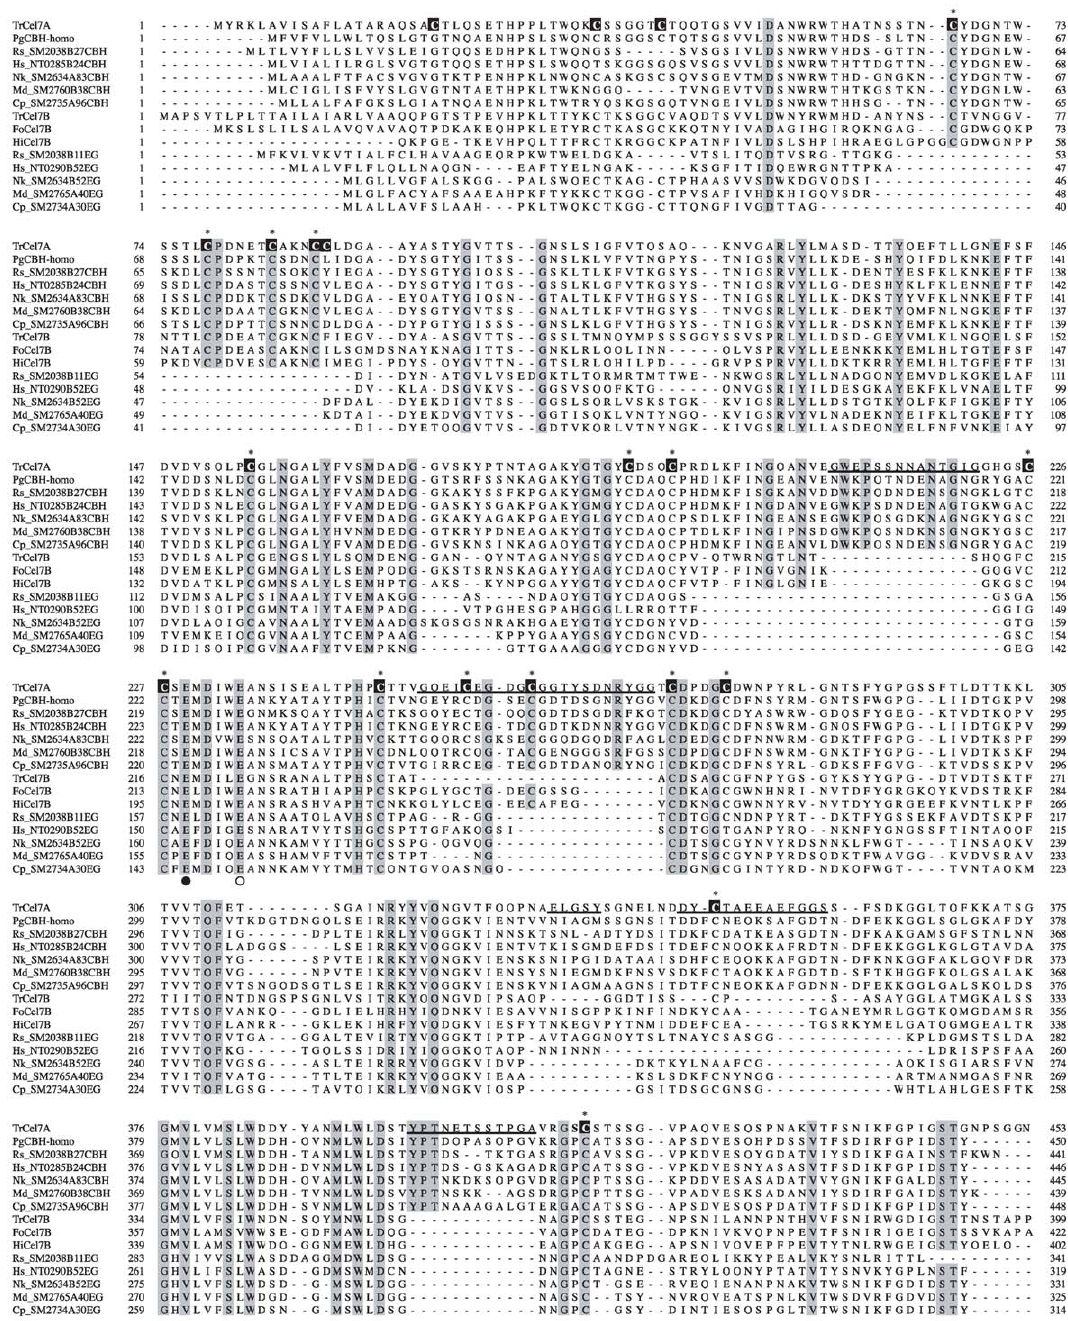
Figure 1. Multiple alignments of symbiotic protist cellulase and catalytic domains of the members of the glycoside hydrolase family 7. Rs, Reticulitermes speratus symbiotic protists ; Hs, Hodotermopsis sjostedti symbiotic protists ; Nk, Neotermes koshunensis symbiotic protists ; Md, Mastotermes darwiniensis symbiotic protists ; Cp, Cryptocercus punctulatus symbiotic protists ; Numbered clones (for example SM2038A27) are clone names of cellulase genes identified in this study from the symbiotic protists of termites; CBH, cellobiohydrolase; EG, endoglucanase; TrCel7A, a cellobiohydrolase component, Trichoderma reesei Cel7A [Uni Prot. P00725]; PgCBH-homo, Pseudotrichonympha grassii PgCBH-homo1 [Q95YH1]; TrCel7B, an endo- b -1,4-glucanase (EG) component, T. reesei Cel7B [P07981]; FoCel7B, an EG component, Fusarium oxysporum Cel7B [P46237]; HiCel7B, an EG component, Humicola insolens Cel7B [P56680]. The alignments were performed using CLUSTAL_W and subsequent manual refinement based on the three-dimensional structures of reference sequences. Arabic numerals denote the number of residues from each N terminal end. Solid and open circles under the column indicate the sites of putative proton donors and general acids/bases, respectively. Shaded columns represent conserved positions within the sequences. White letters with black shading denote cysteine residues composing the disulfide bond of T. reesei Cel7A. The asterisks represent the putative protistan GHF7 CBH homologue cysteine residue sites corresponding to the cysteine residue sites of T. reesei Cel7A. The underlined sequences in TrCel7A indicate the loop-forming regions covering the catalytic tunnel [22,23].